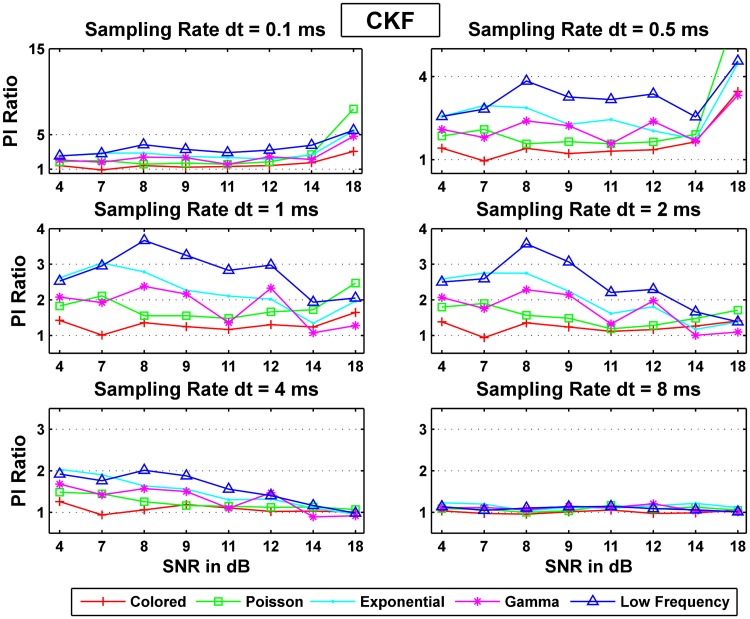
Probability ratios PInoise/PIwhite for the CKF estimation.